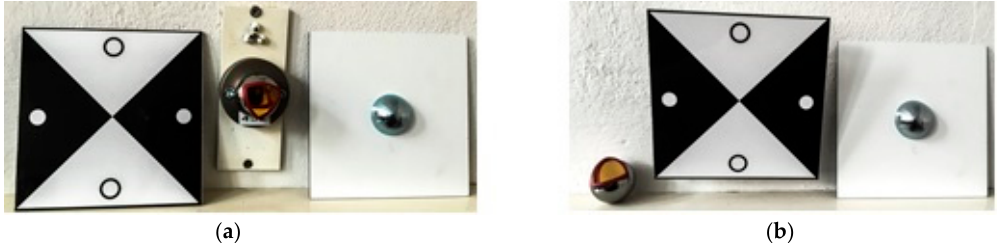
Figure 3. Target mount for the combined adaption of the targets and corner cube reflectors (CCRs). ( a ) target front, target mount with CCR, target back; ( b ) CCR, target mount with target, target back.